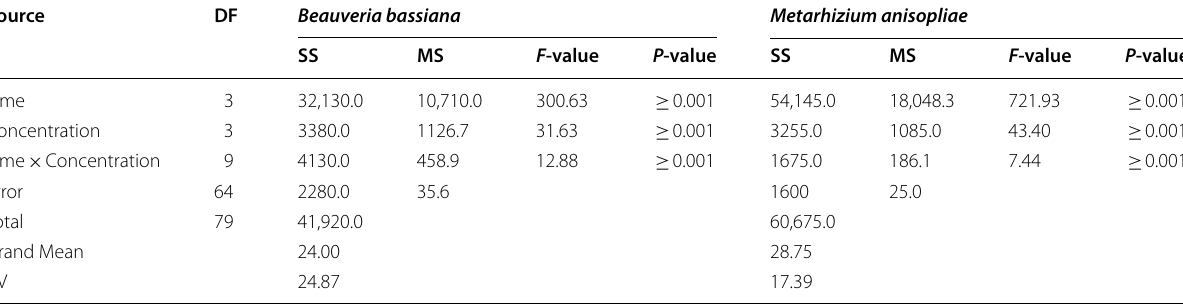
P 0.001 (highly significant) and P ≥